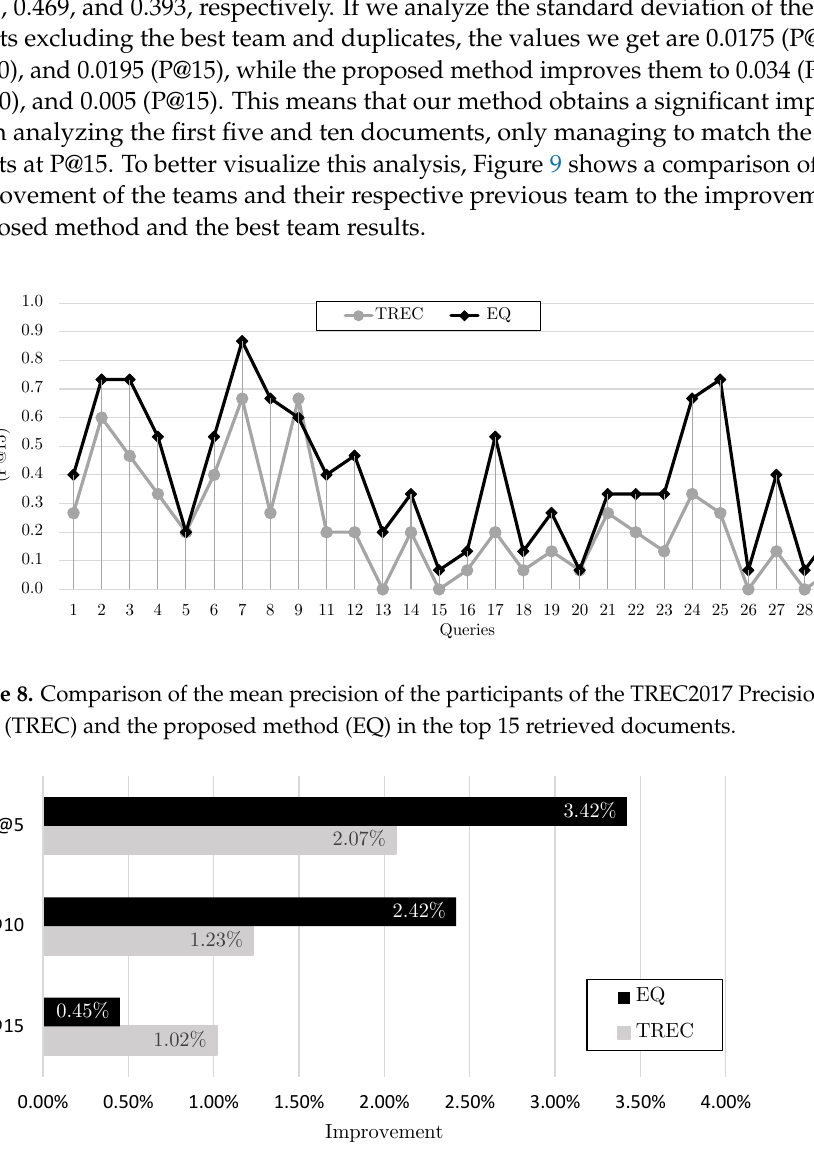
Figure 9. Mean improvement of the best teams at the TREC2017 Precision Medicine Track (TREC) over their respective previous team as compared to the improvement of the proposed method (EQ) over the best team